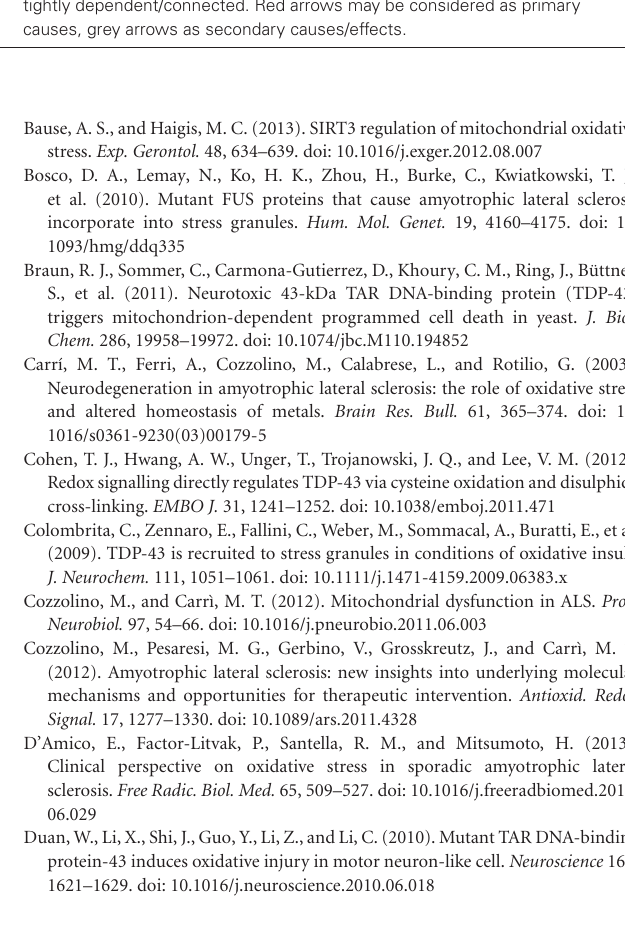
FIGURE 1 | Mitochondrial dysfunction and oxidative stress (OS) are tightly dependent on each other and are the basis of the redox dysregulation in ALS . Increased production of ROS/RNS, the ER stress and, at least in part, transcriptional dysregulation and abnormal RNA processing are all consequences of mitochondrial dysfunction and OS contributing to death of motor neurons. In turn, these pathological events cause other